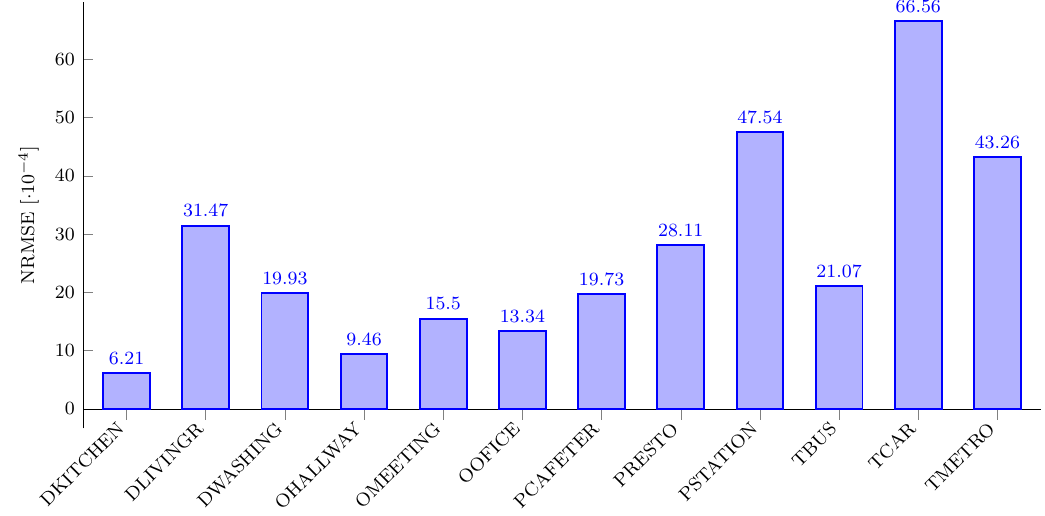
Figure 9. NRMSE between the signal from the reference filter and the signal from the proposed filter for different recordings in the DEMAND